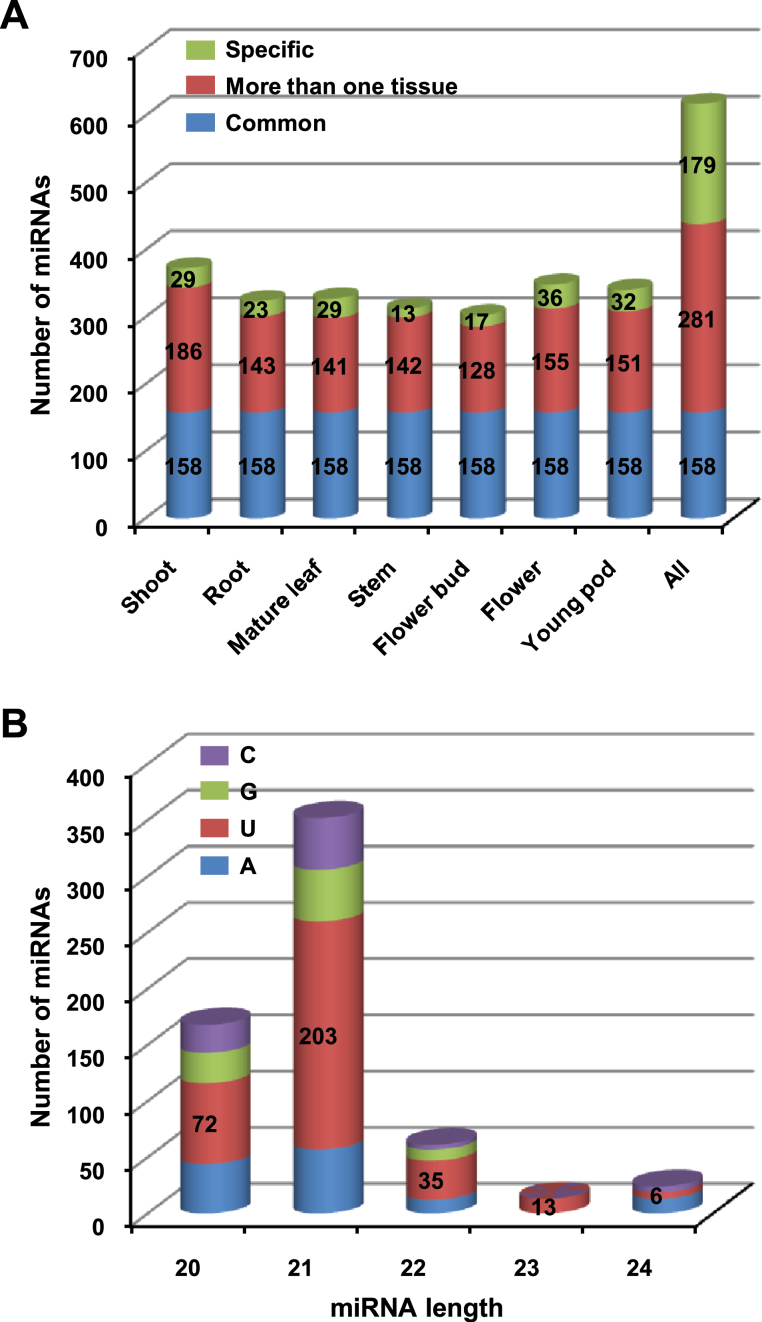
MicroRNA prediction in chickpea tissues. (A) Number of miRNAs identified in seven tissues are shown along with their specificity. The number of miRNAs identified in all the tissues (common), more than one tissue, and those specific to each tissue are given. (B) Size distribution of miRNAs and the identity of the first nucleotide. Most miRNAs are 21-nt long and have 5’-uridine. This figure is available in colour at JXB online.